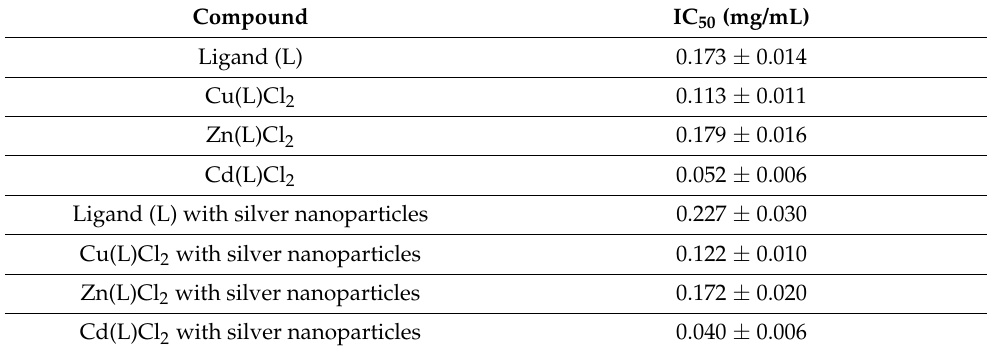
Table 3. In vitro cytotoxic activity of new compounds on cancer cell lines (A549). All values are presented as mean ± standard deviation (SD). IC 50 —50% inhibition of the cell viability, mg/mL.